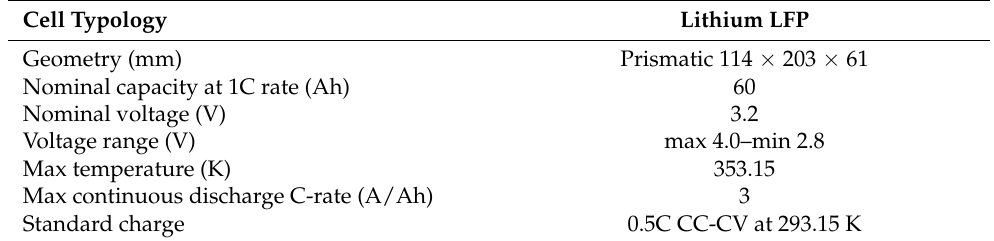
Figure 1. Cell inside the climatic chamber. ( a ) Any labelled thermocouple refers either to cell surface, electrode, or air temperature. ( b ) Detail of the ring probe placed at the cell positive electrode.